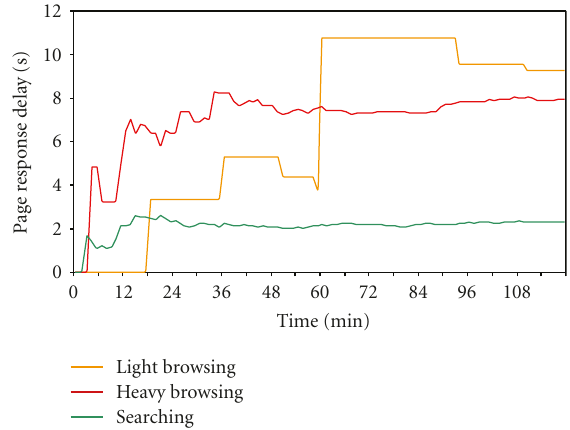
Figure 15: Average web page delivery delay on the Web